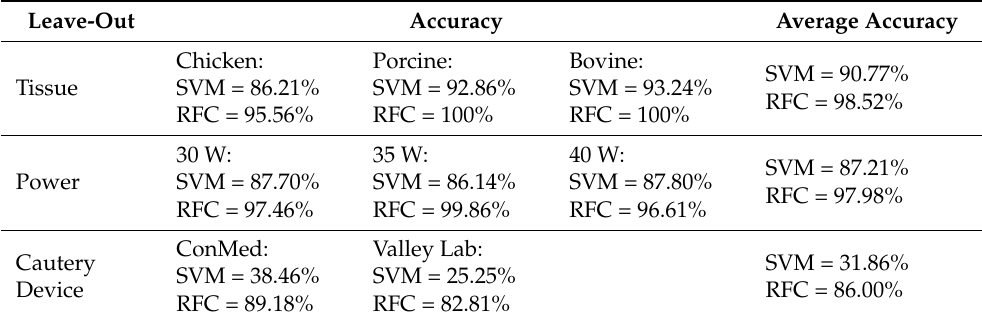
Table 4. Average accuracy from cross-validation detecting cautery state using the first five princi- pal components.